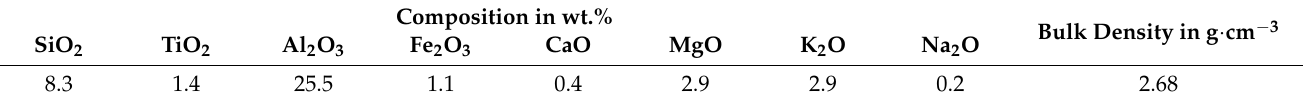
Table 1. Specifications of the kaolinite clay (Sibelco, Westerwald clay 161): oxide content in wt.% according to the supplier and bulk density as determined by helium pycnometry (Micromeritics AccuPyc 1330).